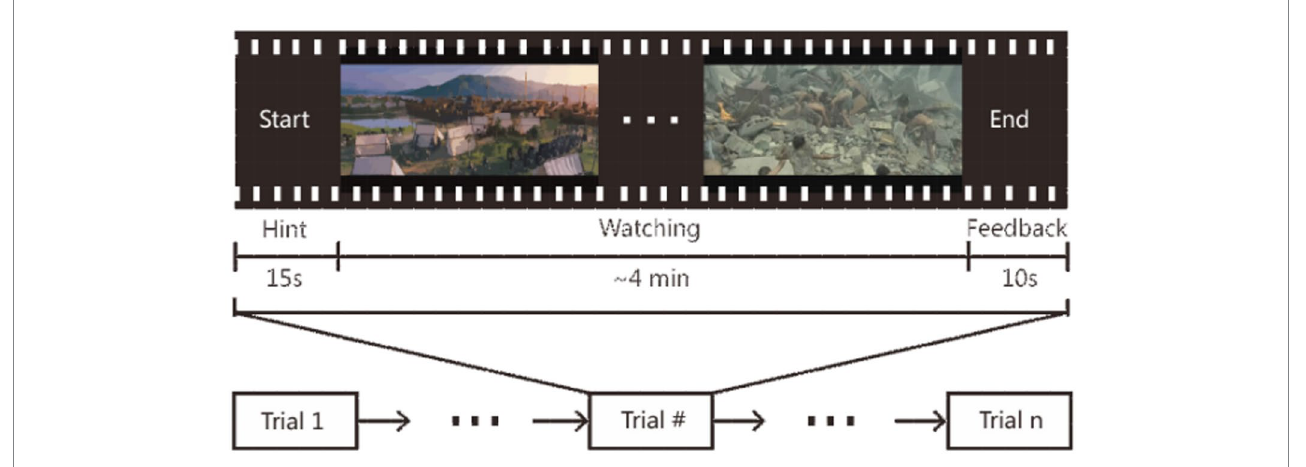
FIGURE 7 Protocol used in the emotion experiment (Zheng and Lu, 2015). Reproduced with permission from IEEE. Licence Number: